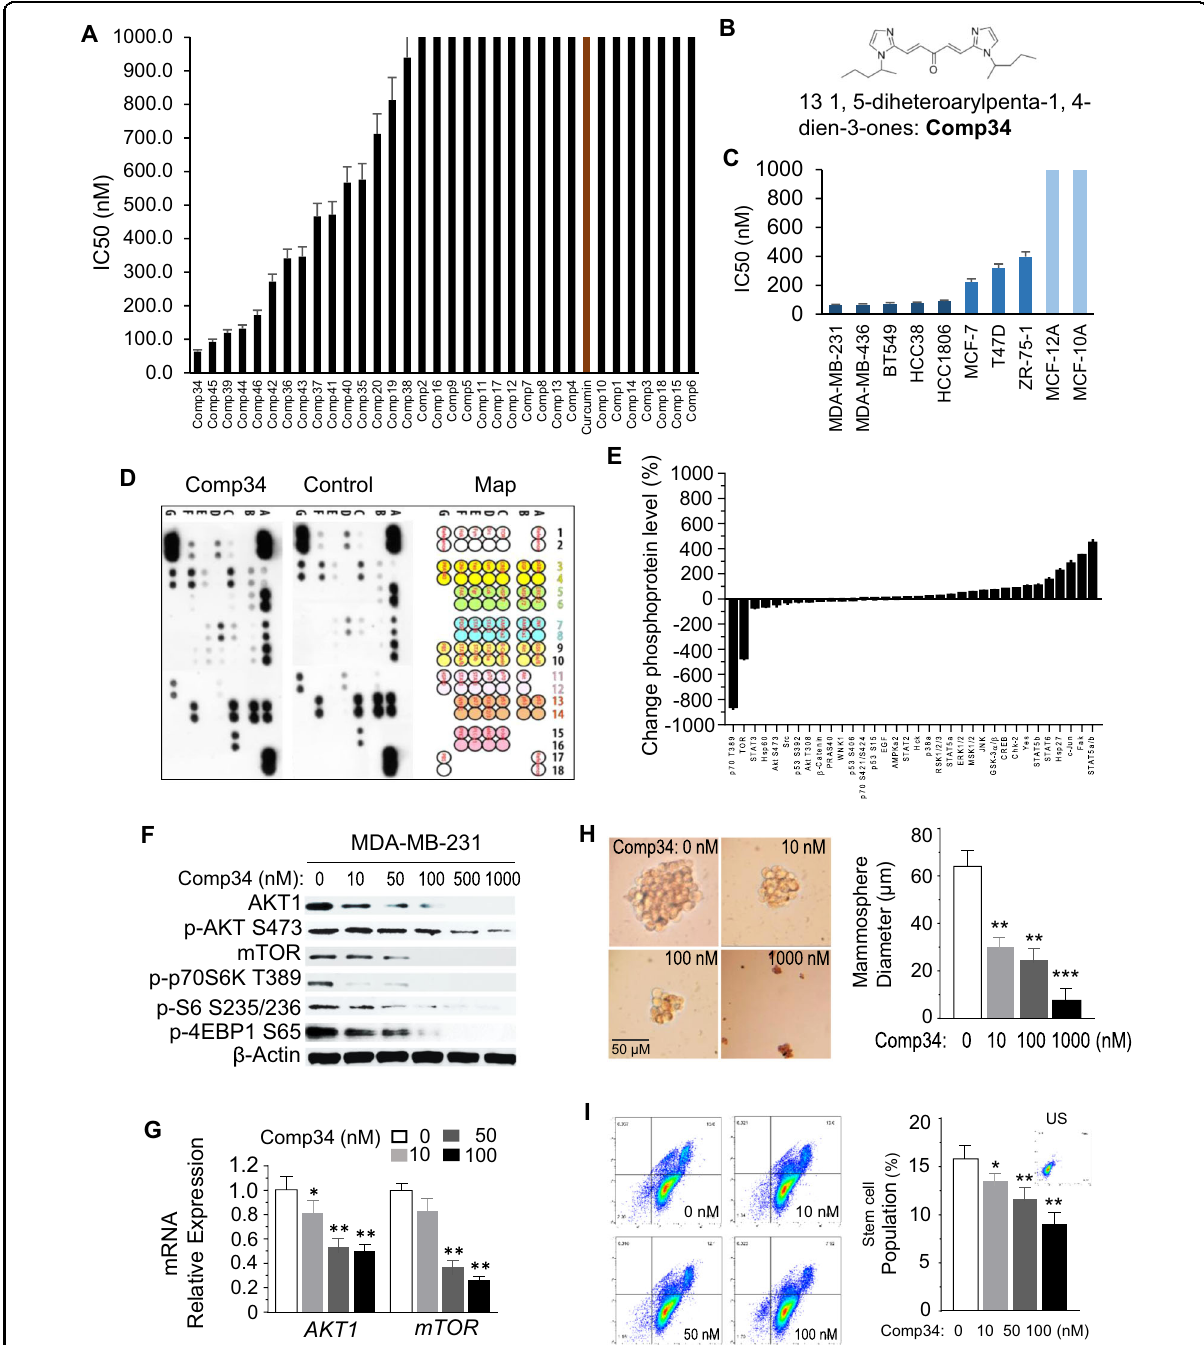
Fig. 1 Comp34 inhibits TNBC cell growth, AKT/mTOR signaling pathway, and stemness. a Screening growth-inhibitory effects of 33 curcumin derivatives on MDA-MB-231 cells. b Chemical structure of Comp34. c IC 50 values exhibited by Comp34 for cytotoxicity against various breast cancer cell lines and nontumorigenic breast epithelial cells. d Phosphorylation status of 34 kinases or transcription factors was assessed by the proteome pro fi ler human phospho-kinase array. e Relative phosphorylation of spots was quanti fi ed by normalizing pixel density of the positive control to 100. f Western blotting (WB) analysis of the expression of AKT1, p-AKT, mTOR, p-p70S6K, p-S6, p-4EBP1 in the MDA-MB-231 cell line upon different concentrations of Comp34 treatment. g Reduction of AKT1 and mTOR mRNA expression in MDA-MB-231 cells treated with Comp34 analyzed by qRT-PCR ( n = 3 replicates). * P <0.05 versus control. h Dissociation of mammospheres after treatment with Comp34. The results represent the mean diameter of mammospheres ±SD, n = 6. i Comp34 reduced the stemness of MDA-MB-231 cells in a dose-dependent manner. Stem cell populations were analyzed by FACS using CD44 and CD24 antibodies. US unstained. The results represent the mean percentage of stem cell population±SD, n =